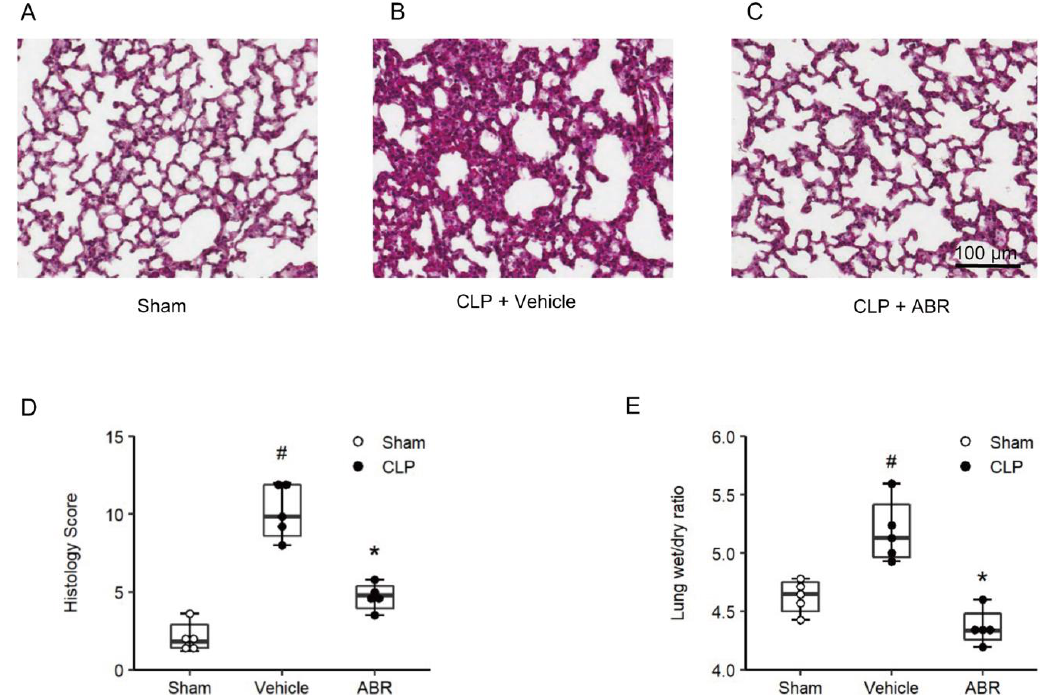
Figure 4. S100A9 promotes septic lung damage. Representative images of ( A ) Sham mice and CLP mice pre-treated with ( B ) vehicle or ( C ) 10 mg/kg of ABR-238901 for 1 h before CLP operation. ( D ) Lung injury score was evaluated by using a predefined scoring system in a double-blinded manner, as described in the method sections. Lung weight wet/dry ratio was used to determine edema formation ( E ). Data are presented as box plots with median (25–75 percentile) and the whiskers extend from the minimum to the maximum levels and dots represent sample values. # p < 0.05 vs. Sham, and * p < 0.05 vs. Vehicle, n = 5. Scale bars = 100 µm.